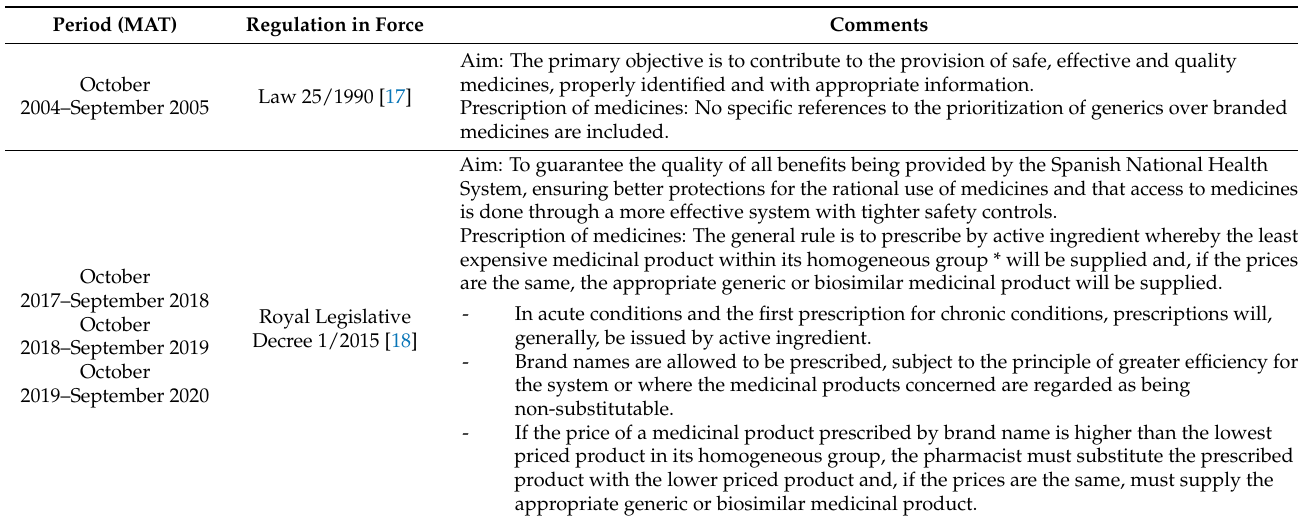
Table 3. Local regulation and general rules regarding the prescription of medicinal products during each period of the